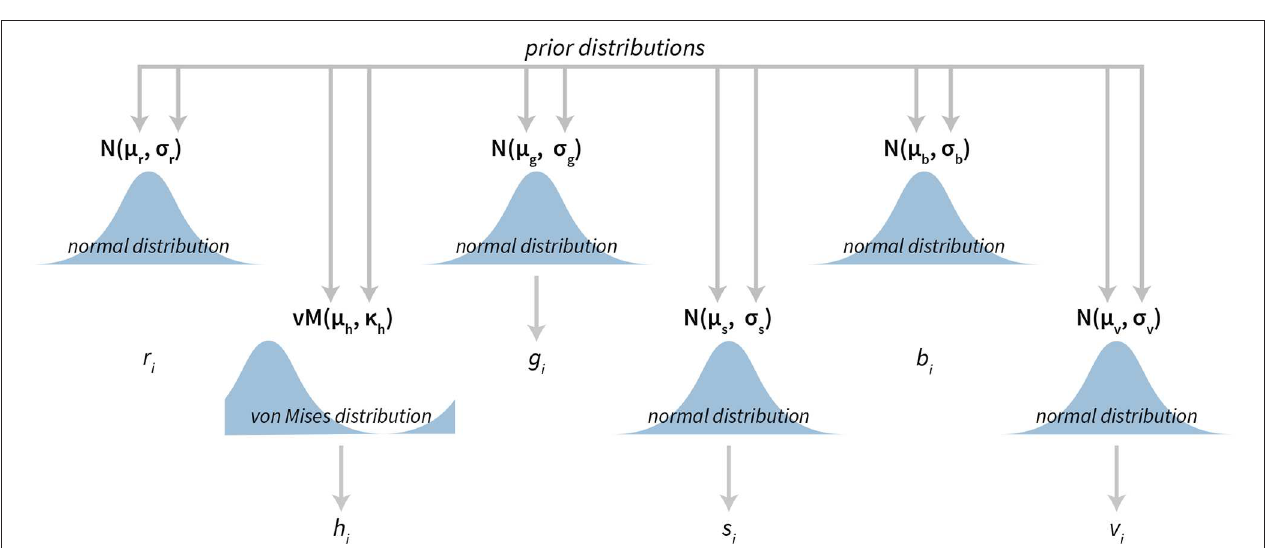
FIGURE 5 | The visualization of the Bayesian color model. The model is composed of six parts. Three parts are used to describe the RGB (red, green, blue) color model components and three parts are used to describe the HSV (hue, saturation, value) color model components. All components, except hue, are modeled with normal distributions, while hue is modeled with the von Mises distribution—a circular normal